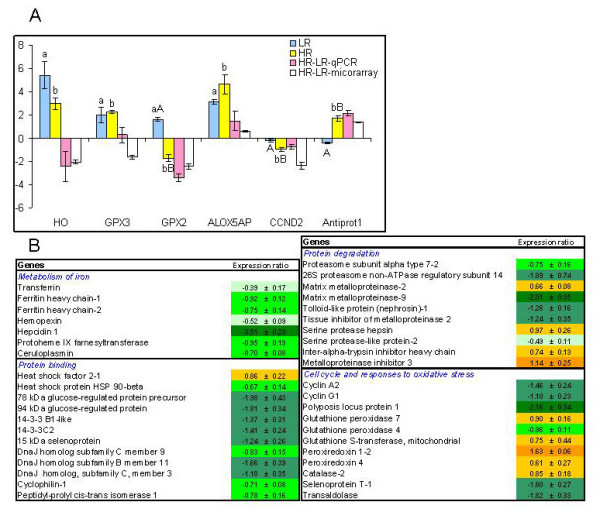
Anti-bacterial effectors, markers of cellular and oxidative stress. A. Real-time qPCR versus microarray analyses. Data for qPCR are ΔΔCt ± SE of 10 HR and 10 LR versus 8 fish in the unchallenged control and data for microarray are mean log2-ER ± SE of 6 HR fish hybridized to a pooled sample of 10 LR fish. Differences between HR and LR determined with microarrays and qPCR are shown. Different capital letters (A, B) denote a difference between challenged fish (HR and LR) while small letters (a, b) denote a difference between challenged and control fish (ANOVA, P < 0.05). HO - heme oxygenase; GPX3 - plasma glutathione peroxidase; GPX2 - gastrointestinal glutathione peroxidase; ALOX5AP arachidonate 5-lipoxygenase-activating protein; CCND2 - G1/S-specific cyclin D2; Antiprot1 - alpha-1-antiproteinase-like protein. B. Microarray results, examples of differentially expressed genes with significant differences between vaccinated and unvaccinated fish (t-test, n = 6 and 5, p < 0.05). Results for unvaccinated fish are not shown, data are log2-ER ± SE.